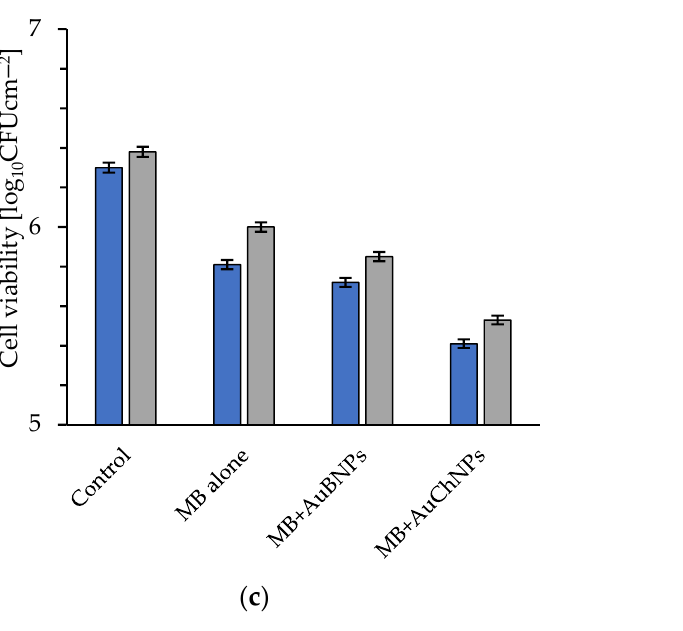
Figure 3. Effect of MB (Methylene Blue), MB + AuBNPs, and MB+AuChNPs (Methylene Blue + gold nanoparticles mixture) on the viability of biofilm formed on the surface of stainless steel discs by S. aureus 3374 ( a ); S. aureus 3375 ( b ); S. aureus 3515 ( c ); S. aureus 3690 ( d ) after exposure to laser light for 30 min (energy fluence was 189 J cm − 2 ). Average ±SD of three independent experiments is shown; in all groups, p < 0.05. Age of biofilm: (24 h) = biofilm formed on the steel surface within 24 h; (48 h) = biofilm formed on the steel surface within 48 h.